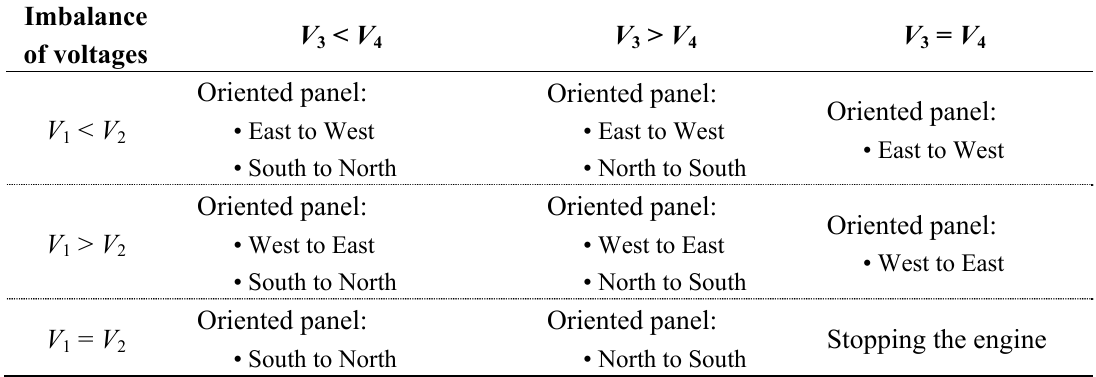
Table 2. Positions of the solar panel by the imbalance of voltages ( V sensors